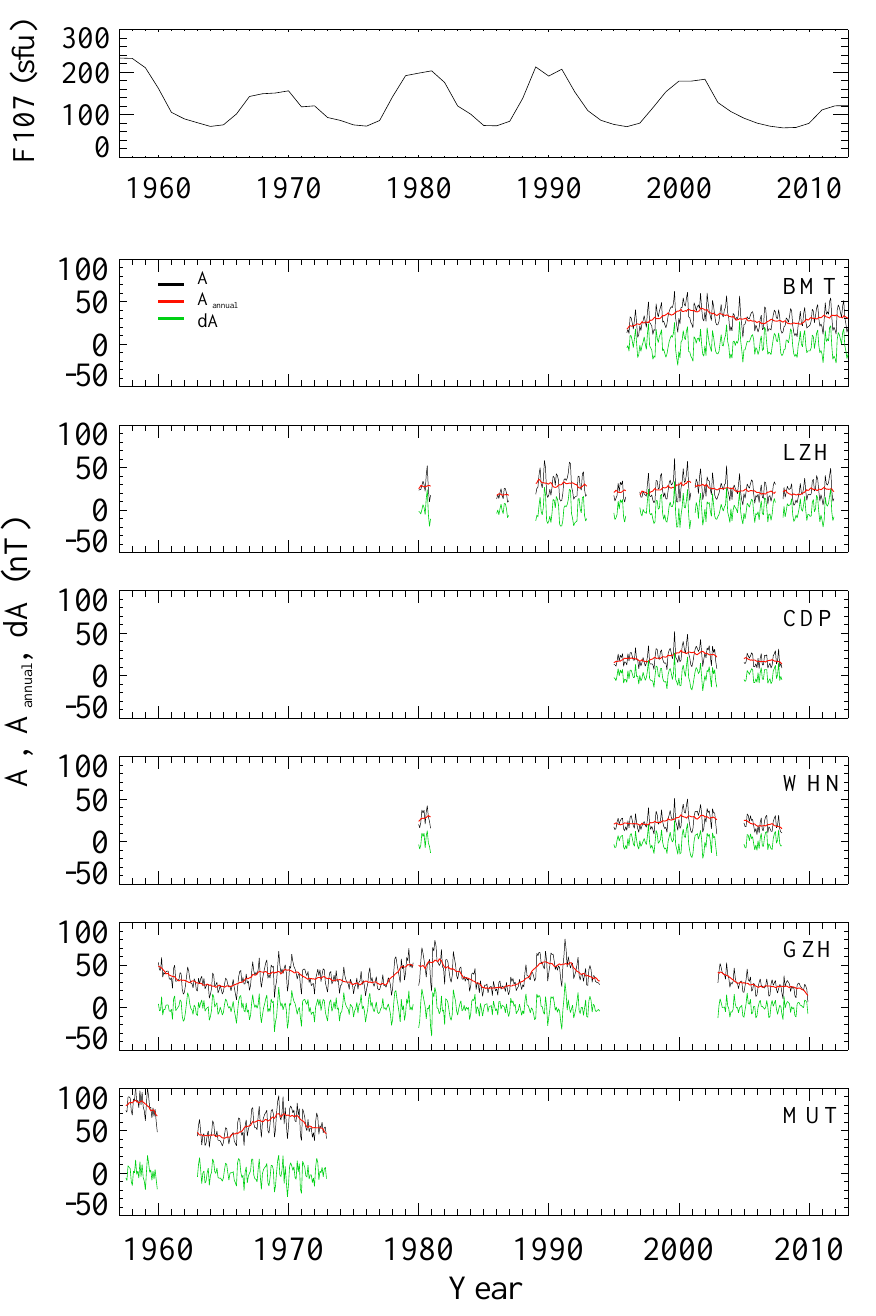
Figure 4. ( Top ): Yearly averaged F107 index (1957–2013). ( Bottom ): Month-to-month variations at each observatory of the SqH daily range (A, black curves); 12-month smoothing of the SqH daily range (A annual , red curves) and their variability (dA, green curves).